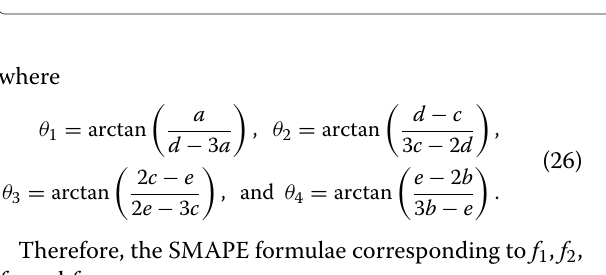
Fig. 7 Octant portion of the chamfer polygon generated by a 7 × 7 mask. l 1 : ( d − 3 a ) y + ax = r , l 2 : ( 3 c − 2 d ) y + ( d − c ) x = r , l 3 : ( 2 e − 3 c ) y + ( 2 c − e ) x = r , and l 4 : ( 3 b − e ) y + ( e − 2 b ) x = r . ∠ AOE = 45 ◦ and corner points are A ( r ,0 ) , Q ( r ,0 ) , and R ( r ,0 P ( r d − c 2 c − e e − 2 b